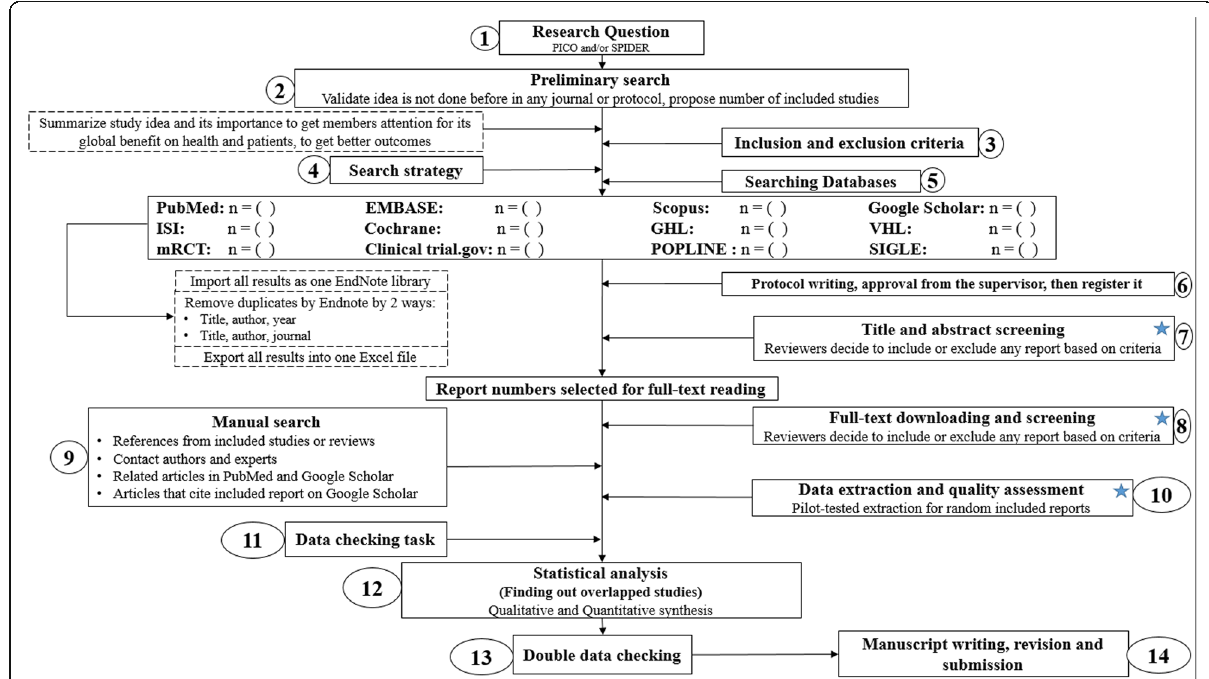
Fig. 1 Detailed flow diagram guideline for systematic review and meta-analysis steps. Note : Star icon refers to “ 2 – 3 reviewers screen independently